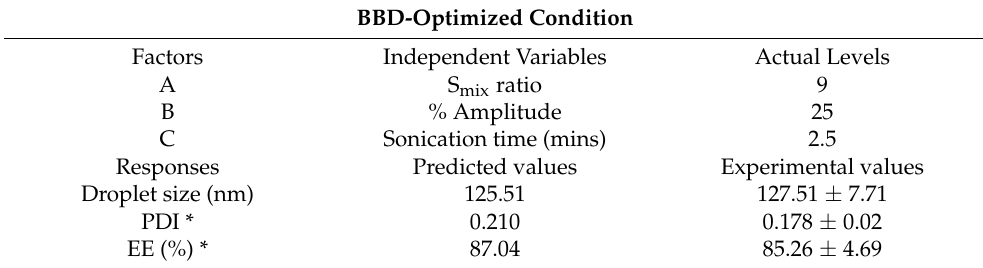
Table 4. Predicted and experimental values for an optimized condition for Que-NE.